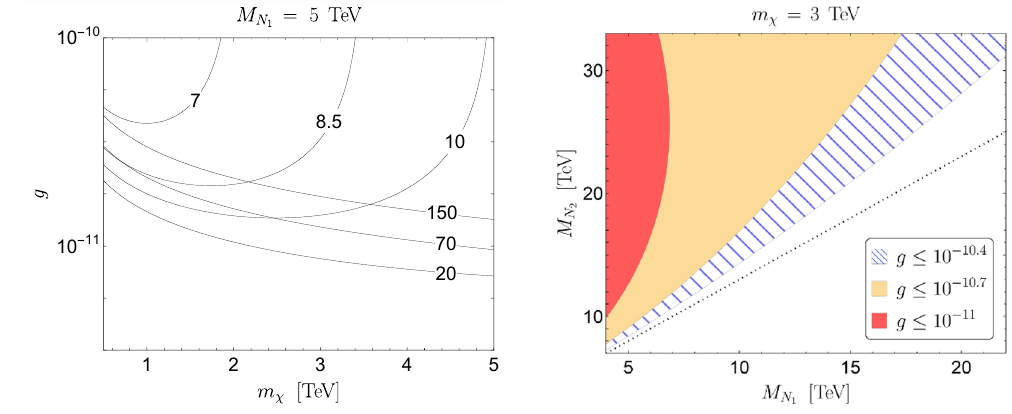
Figure 4 . The allowed region to realize the DM relic abundance in ( m (cid:31) ; g )- and ( M N See the text for